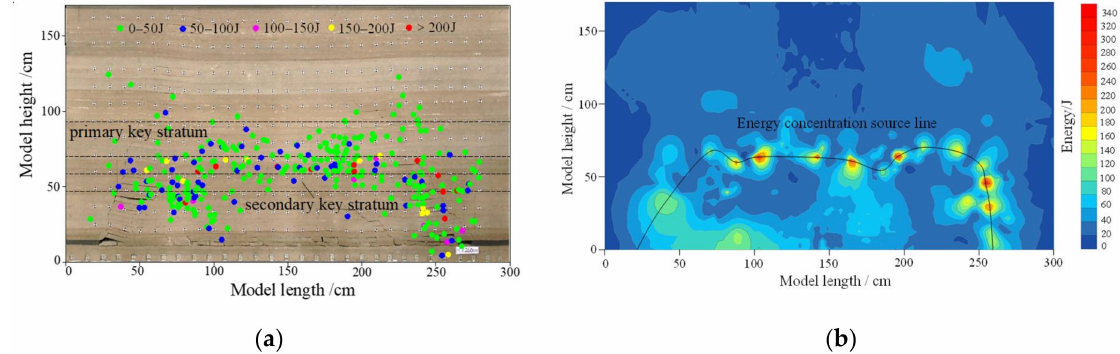
Figure 6. The microseismic events and cloud image of energy distribution of the whole excavation process: ( a ) microseismic location distribution; ( b ) cloud image of microseismic energy